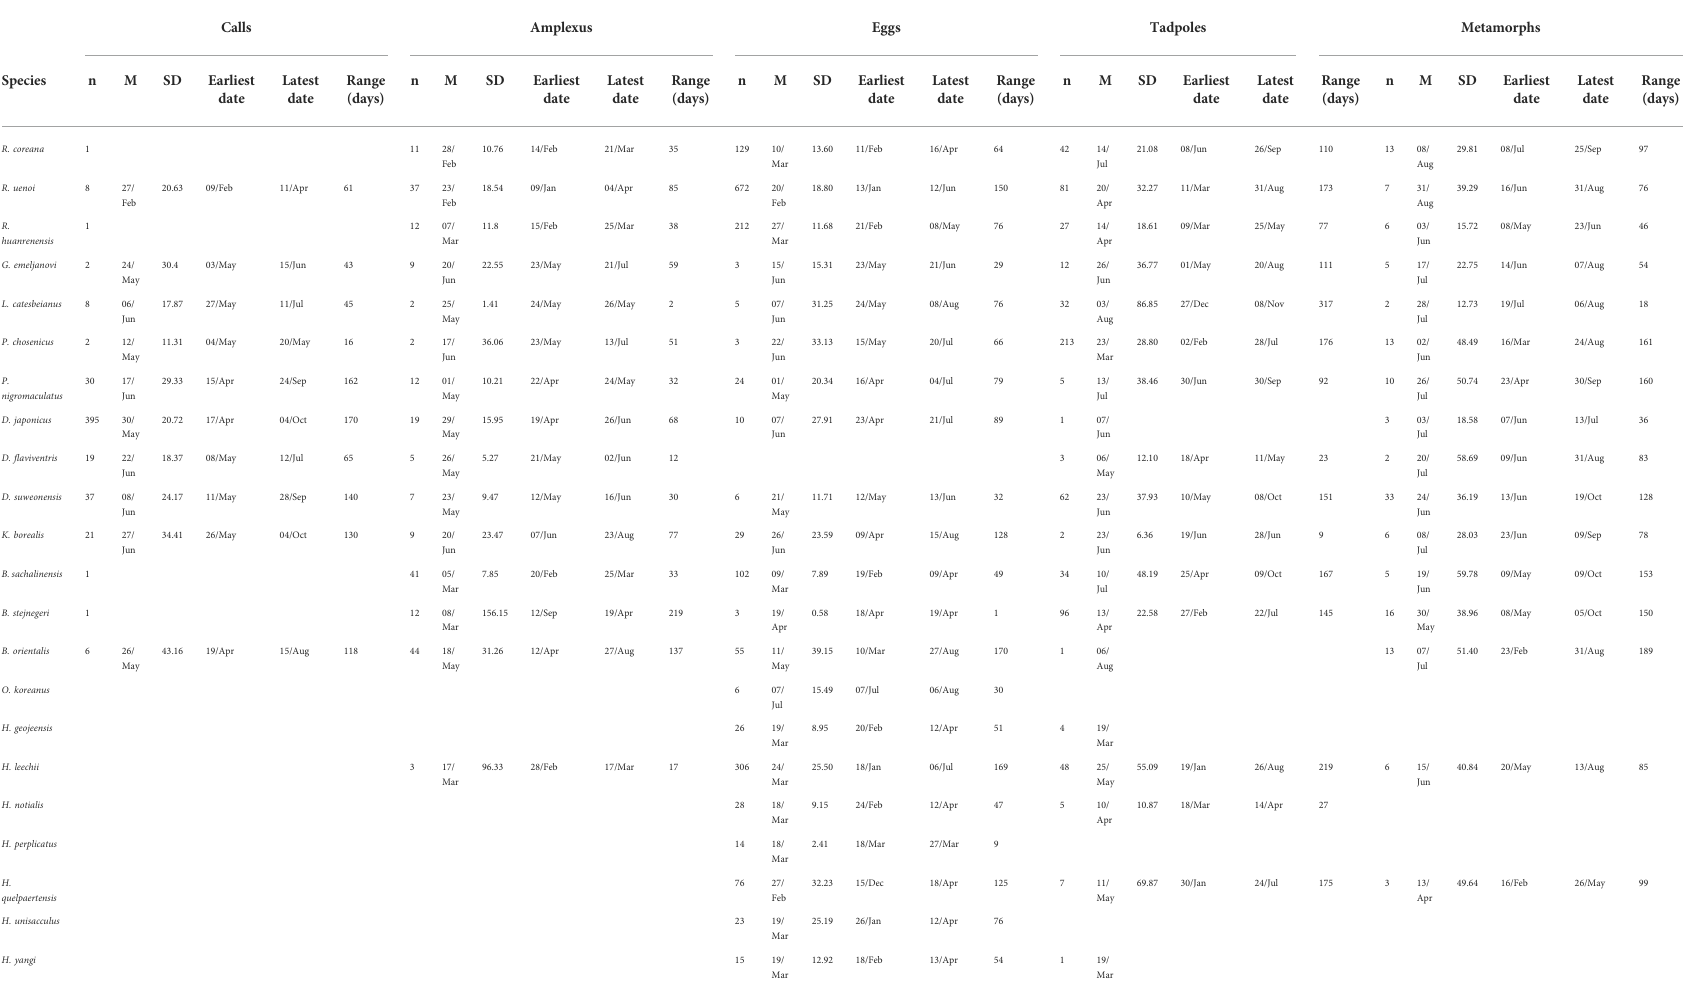
TABLE 3 Details ( n = total observation, M is median, SD = standard deviation) on the phenology of calls, amplexus, eggs, tadpoles and metamorphs for Korean amphibians. The analysis is based on 8,763 citizen science observations collected between 02 March 1997 and 01 December 2020 downloaded from the platform iNaturalist. Calls Amplexus Eggs Tadpoles Metamorphs